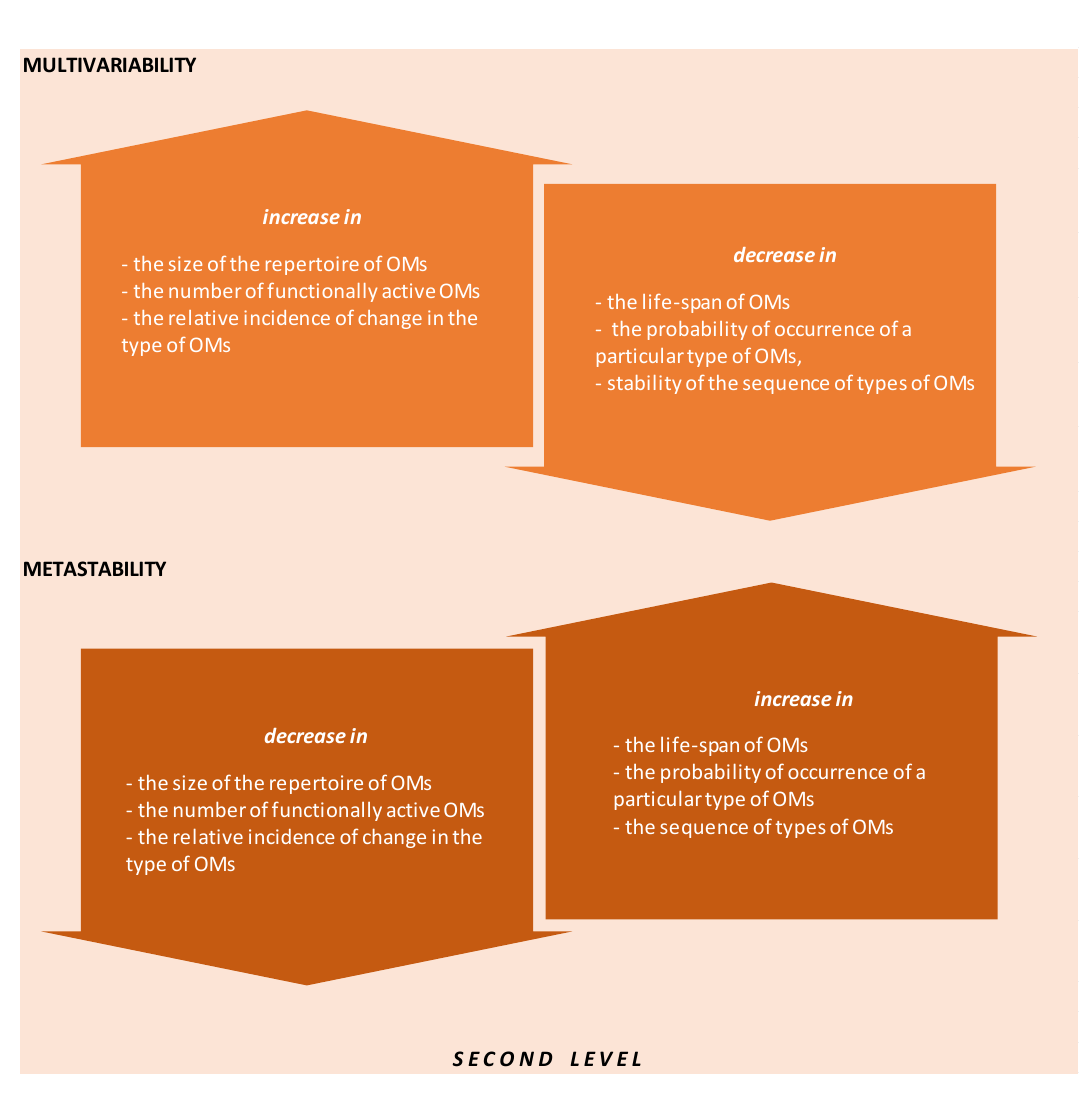
Figure 2. The second level of multivariability and metastability measured by qEEG. In this context, the participation of cortex areas in the organization of a common func- tional act is reflected not so much by the presence of a shared qEEG rhythm in different EEG channels (distant neuronal ensembles) but by the systematic synchronization of the moments of switching (RTPs) between qEEG oscillatory modes in the different cortex ar- eas. The fact that operational synchrony is sensitive to the morpho-functional organiza- tion of the cortex rather than the volume conduction and/or reference electrode differs from surrogate data (random combination of RTPs) and is functionally sensitive to differ-